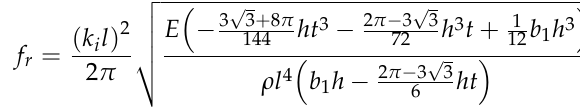
Figure 5. The ripple effect of a doubly-clamped beam: ( a ) a schematic diagram of the model; ( b ) the coordinate sketch-map of single ripple as one unit.